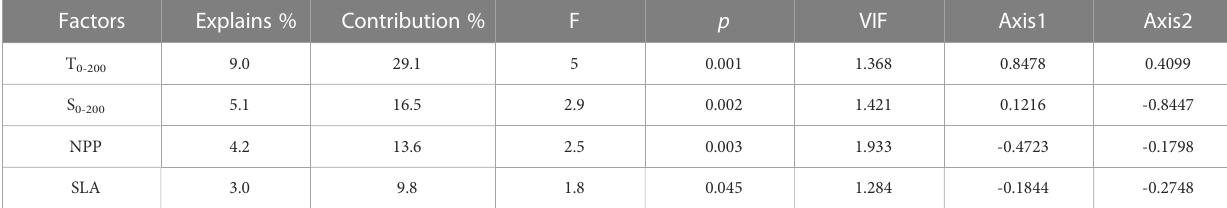
TABLE 2 Conditional effects and the intra-set correlations of environmental factors with the fi rst two axes of CCA. Factors Explains %